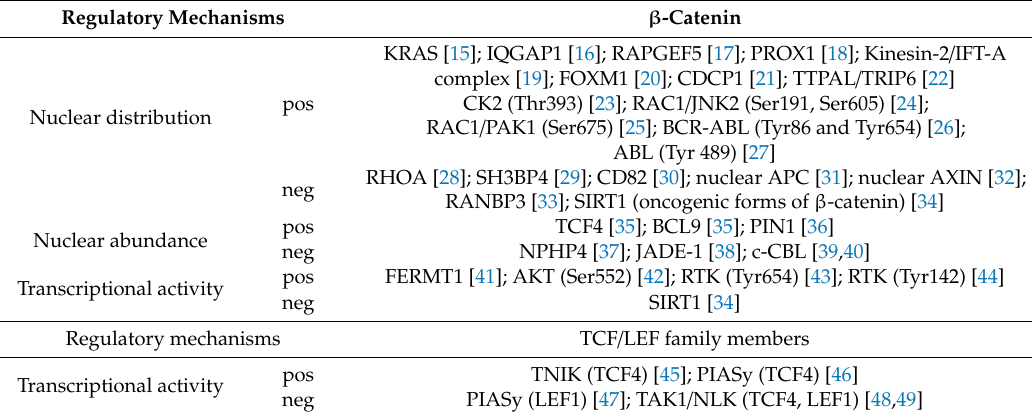
Table 1. Summary of regulators influencing nuclear distribution, nuclear abundance and transcriptional activity of β -catenin and TCF / LEF family